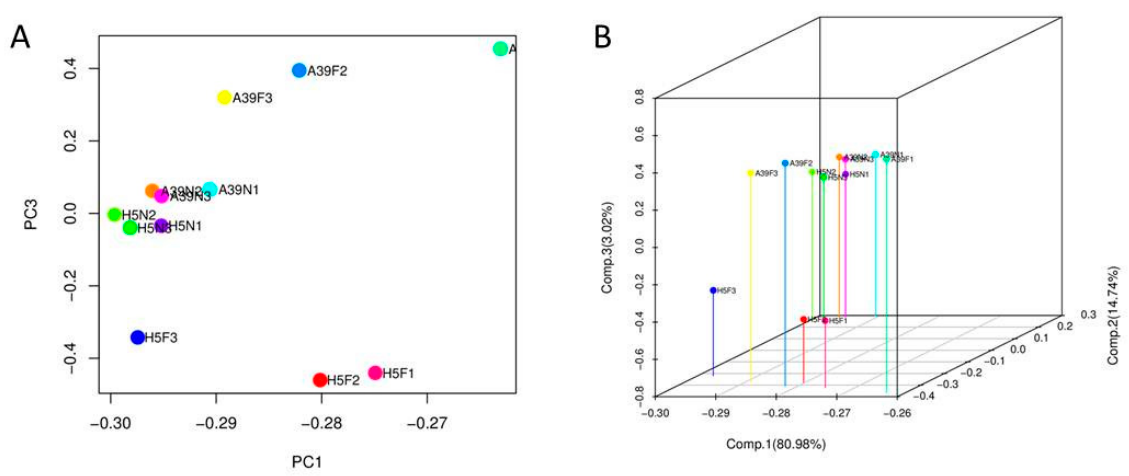
Figure 3. Principal components analysis (PCA) of ‘A39’ and ‘H5’ (n = 12). ( A ) Two-dimensional chart produced with the clean data from the samples. ( B ) Three-dimensional chart produced with the clean data from the samples.